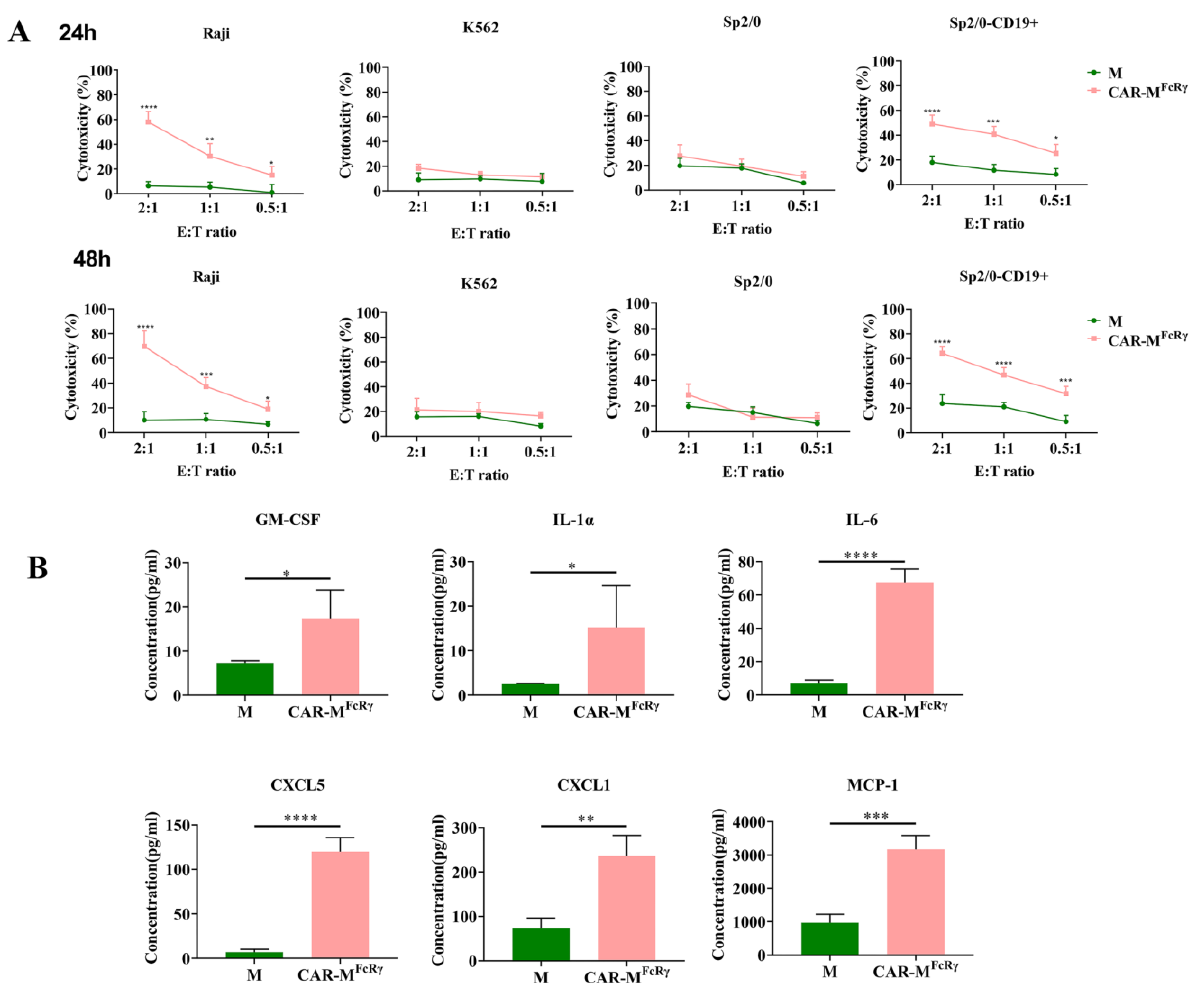
Figure 3. The cytotoxicity of CAR-M FcRγ against antigen-positive and antigen-negative cells and cytokine/chemokine analysis. ( A ) FACS counting-based killing assay of Raji, K562, Sp/20, Sp2/0-CD19+ cells by GFP-M (M) control or CAR-M FcRγ at 24 or 48 h at dif- ferent E:T ratios (2, 1 or 0.5). Data represent the mean ± SD of n =3 biological replicates. ( B ) Cytokine/chemokine released by M or